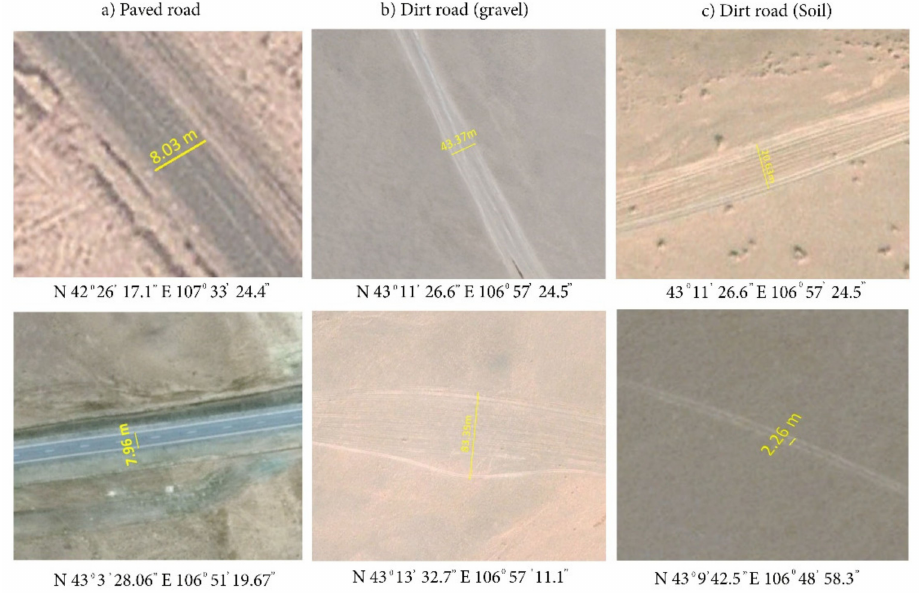
Figure 3. Corridors and the total width of the road types at selected points. ( a ) The paved road; ( b ) gravel-road corridors; ( c ) soil-road corridors.